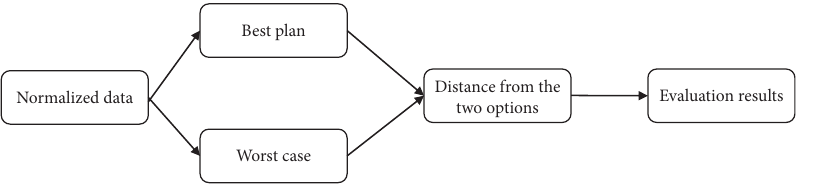
Figure 3: *e steps of the TOPSIS study. Table 2: Smart pig game